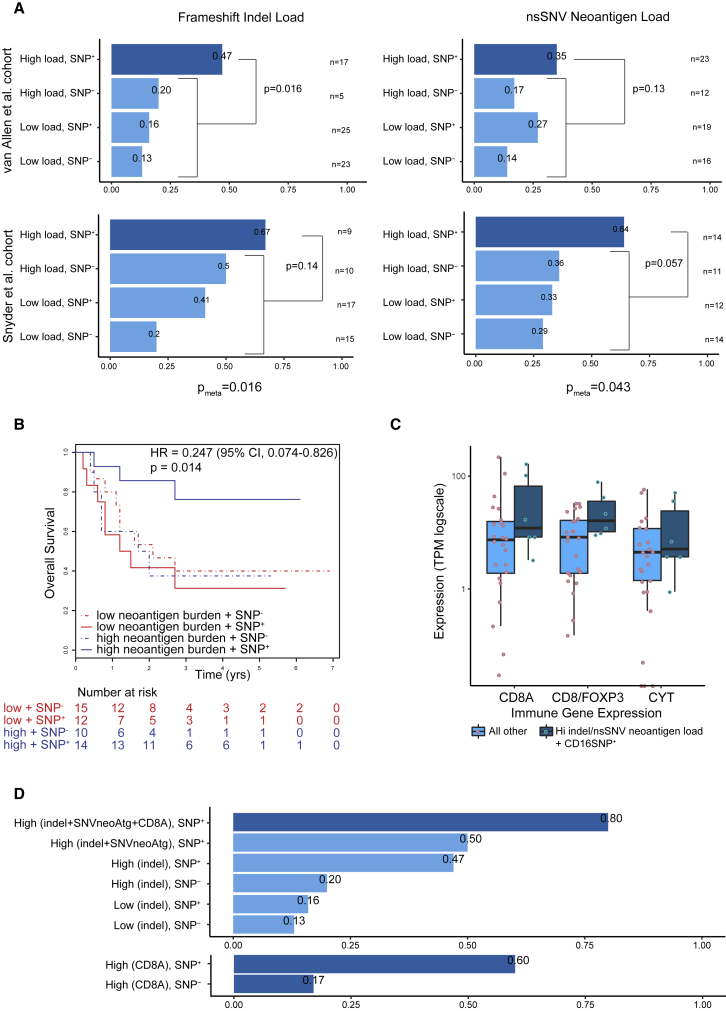
Human FcγR Polymorphisms Impact Response to Ipilimumab in Patients with Advanced Melanoma(A) Anti-CTLA-4 response rate analysis in two separate cohorts of advanced melanoma patients, as published by Van Allen et al. (2015) (top) and Snyder et al. (2014) (bottom). For each analysis patients are split into four groups: (1) high load of somatic mutations and presence of germline high-affinity CD16a-V158F polymorphism (SNP+), (2) high load of somatic mutations and absence of germline CD16a-V158F polymorphism (SNP−), (3) low load of somatic mutations and SNP+, and (4) low load of somatic mutations and SNP−. Both homozygous and heterozygous patients were included in the SNP+ groups. Two different measures of mutational load were tested (McGranahan et al., 2016, Turajlic et al., 2017): (left) the number of frameshift indel mutations and (right) the number of non-synonymous single-nucleotide variant (nsSNV) neoantigens. In all cases, high and low are defined as above or below the median value, respectively. In each analysis, patient group (1) is tested for a difference in response rate compared with groups 2–4 using Fisher's exact test. Meta-analysis for each measure (pmeta), across the two patient cohorts was conducted using the Fisher's method of combining p values from independent tests.(B) Survival analysis of patients with advanced melanoma treated with anti-CTLA-4 with low (≤median) or high (>median) predicted neoantigen burden with or without the germline polymorphism CD16a-V158F. Log rank p values are displayed with hazard ratio (HR) and confidence interval (CI). In (A) and (B), patients from the Snyder et al. (2014) cohort treated with tremelimumab (n = 3) were excluded.(C) Boxplot showing the expression level of key immune markers from patients with available RNA-seq data from the Van Allen et al. (2015) cohort (n = 30): CD8A, ratio of CD8A divided by FOXP3 and cytolytic activity (defined as the log-average of GZMA and PRF expression). Patients are grouped into responders with high mutational load (based on either measure) and SNP+, compared with all other patients. Boxes show the middle quartile (25%–75%); horizontal bars represent the median; whiskers show either the maximum and minimum values in the dataset or ±1.5 times the interquartile range if the maximum and minimum values exceed these limits. TPM, transcripts per million.(D) Extension of the response rate analysis from (A), top left, with the following additional two groups: high mutational load (for both measures) plus high CD8A expression (>median) plus SNP+ and high mutational load (for both measures) plus SNP+ (top bar graph). In addition, high CD8A expression plus SNP+ and high CD8A expression plus SNP− were compared (bottom bar graph). Due to the small RNA-seq sample size (n = 30), differences were not tested for statistical significance in (C) and (D).See also Figure S5.